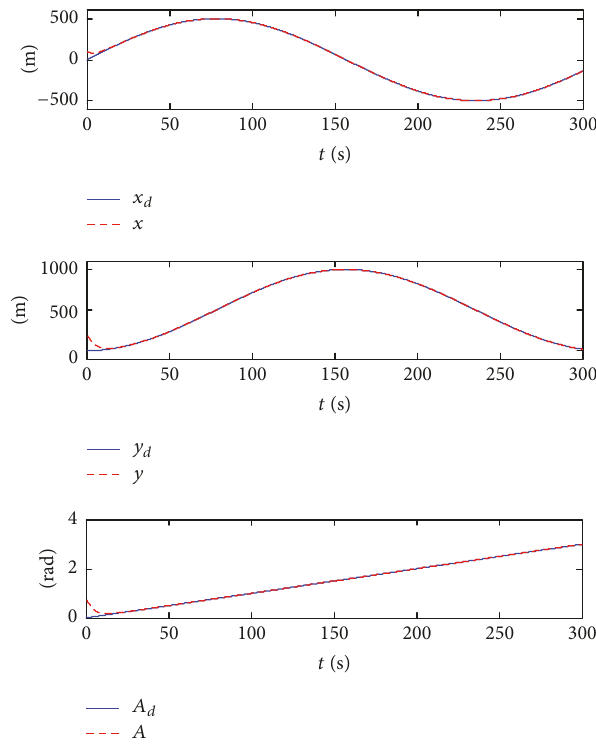
Figure 2: Curves of expected trajectory 𝜂 𝑑 and actual trajectory 𝜂 .